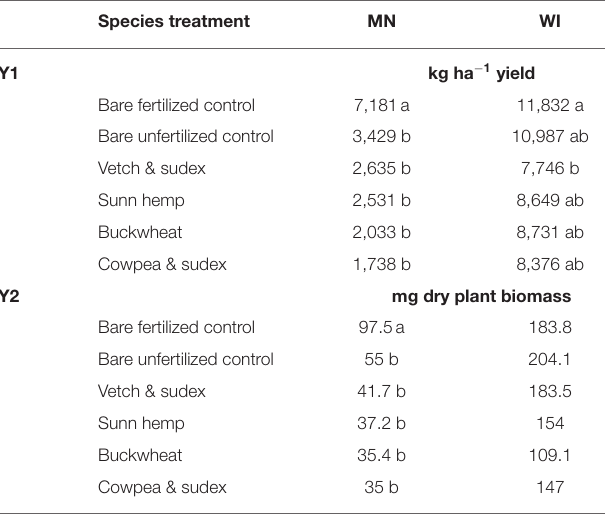
TABLE 4 | Fall cash crop yield in Y1 and plant biomass in Y2 by location for each species, averaged over duration in the absence of interaction effects. Species